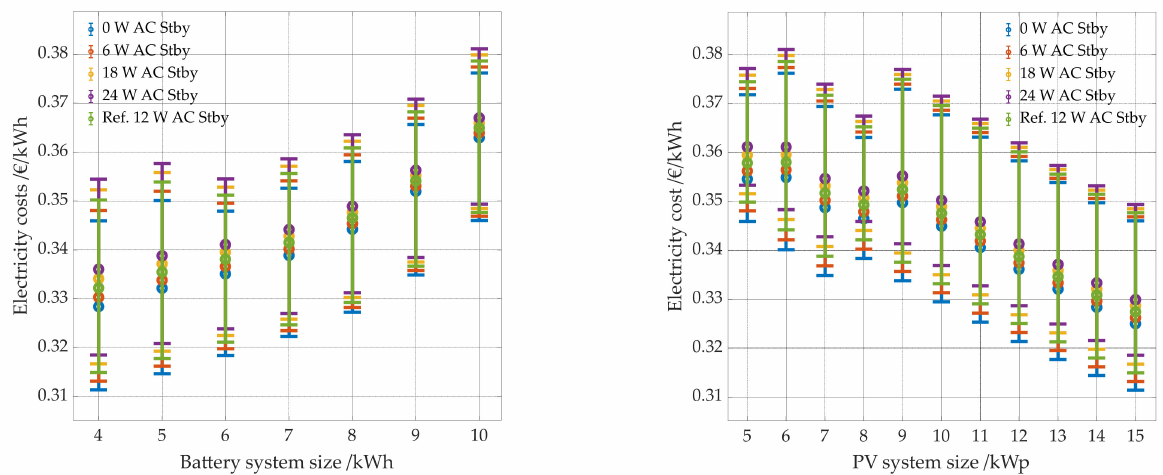
Figure 19. Electricity costs per kWh as a function of battery system size ( left panel) and PV system size ( right panel). The results for different levels of AC standby consumption are shown in color. The reference case with an AC standby consumption of 12 W is shown in green.